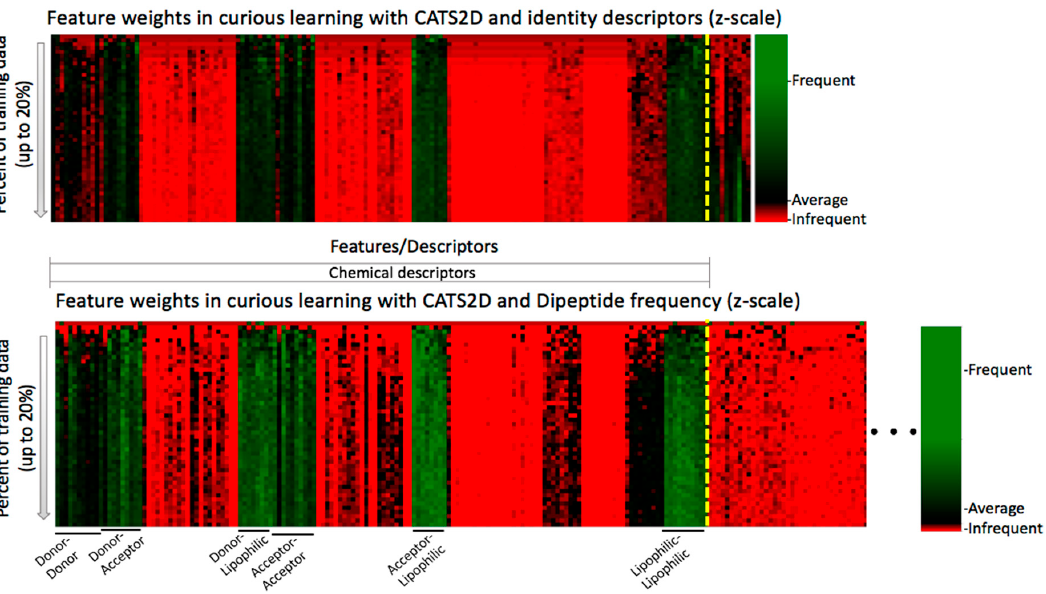
Figure 4. Feature weight time series show the evolving relative weights of each descriptor used, oriented from top (initial iterations) to bottom (later iterations). A yellow dotted line denotes the boundary between chemical and protein descriptors. Order of compound descriptors is preserved between top and bottom panels. Protein dipeptide frequencies are less weighted yet still non-trivial. The pharmacophoric patterns that most influence decision making are labeled. (Bottom panel—truncated figure. Original, full heatmap can be found in Figure S3a.).